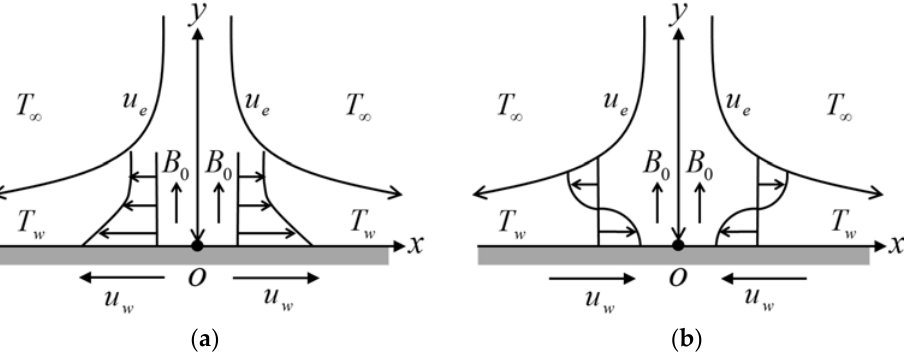
Figure 1. The flow configuration of ( a ) stretching and ( b ) shrinking sheets.